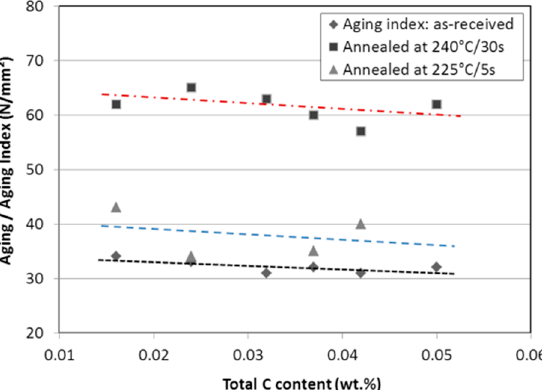
Figure 3. The effect of total C content on aging index and age hardening (The lines are for reference